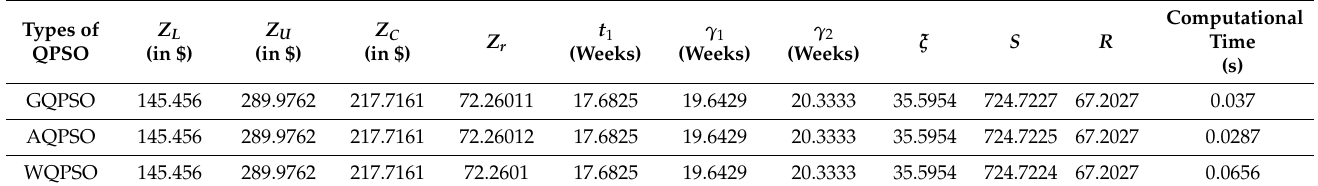
Table 3. Worst found results for Case-I of Example